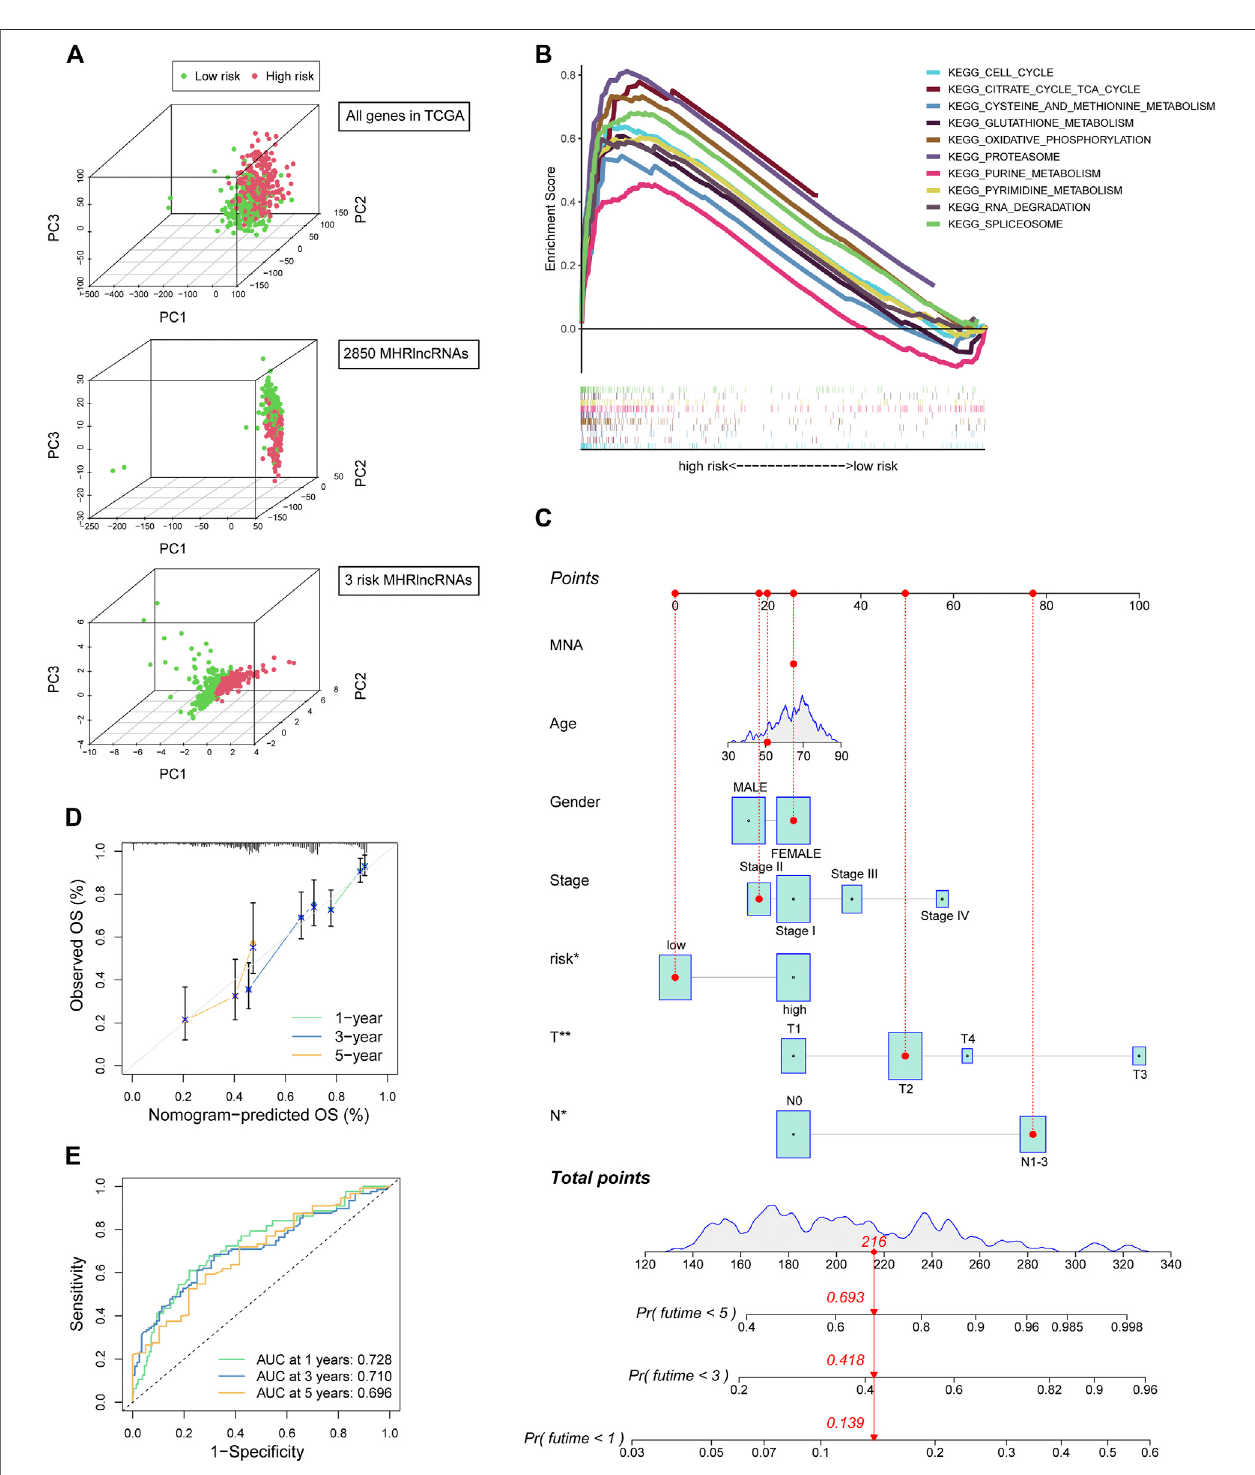
FIGURE 4 | PCA and GSEA analyses of the MHLncSig and construction of a prognostic nomogram. (A) PCA based on the total gene expression pro fi les, 2,850 MHRlncRNAs,andtheMHLncSigcategorizedbythreeriskMHRlncRNAs. (B) GSEAanalysisofthehigh-riskgroupcalculatedbyMHLncSig. (C) Anomogrampredicting 1-, 2-, and 3-year OS of LUAD cancer. (D) The calibration plot of the nomogram. (E) ROC curves of the prognostic nomogram at 1, 3, and 5 years.